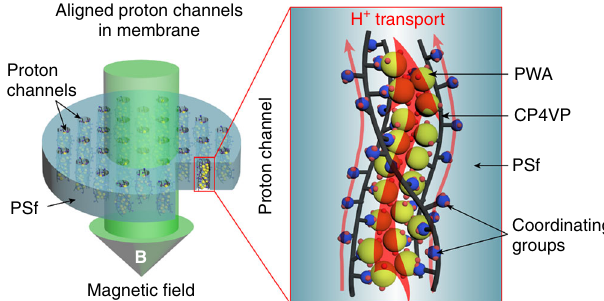
Fig. 8 Conceptual diagrams. Magnetically aligned composite membrane and proton transport in the aligned channels are shown. CP4VP and PWA, both proton-conducting components, form TP-oriented proton channels, allowing proton transport along the coordinating ferrocyanide group/PWA complex and the uncombined coordinating ferrocyanide groups. CP4VP: ferrocyanide-coordinated poly(4-vinylpyridine); PWA: phosphotungstic acid; PSf: polysulfone;